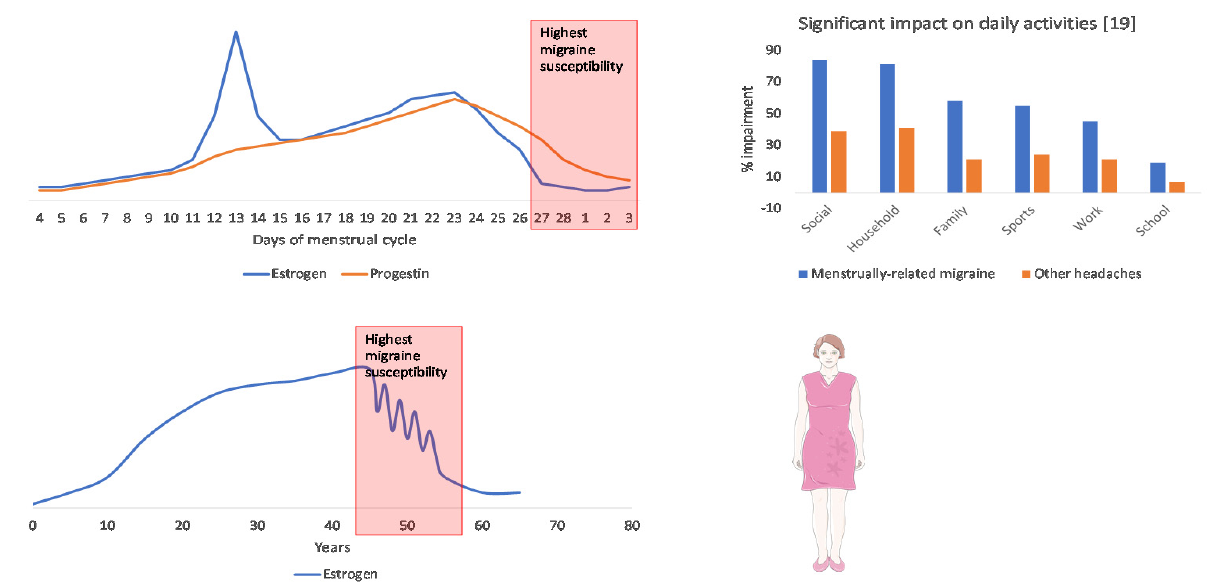
Figure 3. Graphical representation of the menstrual and perimenopausal periods of increased susceptibility to migraine and women’s quality of life impairment. The panels on the left indicate the levels of female sex hormones during the menstrual cycle (above) and the years of women’s life (below). The graph on the right shows the proportion of women reporting impairment of daily activities due to menstrual-related migraine (blue columns) compared with other headaches (orange columns; data from [19]).